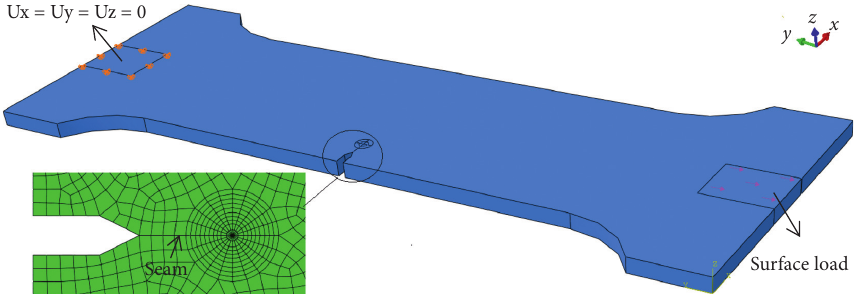
Figure 3: Numerical model of specimens without